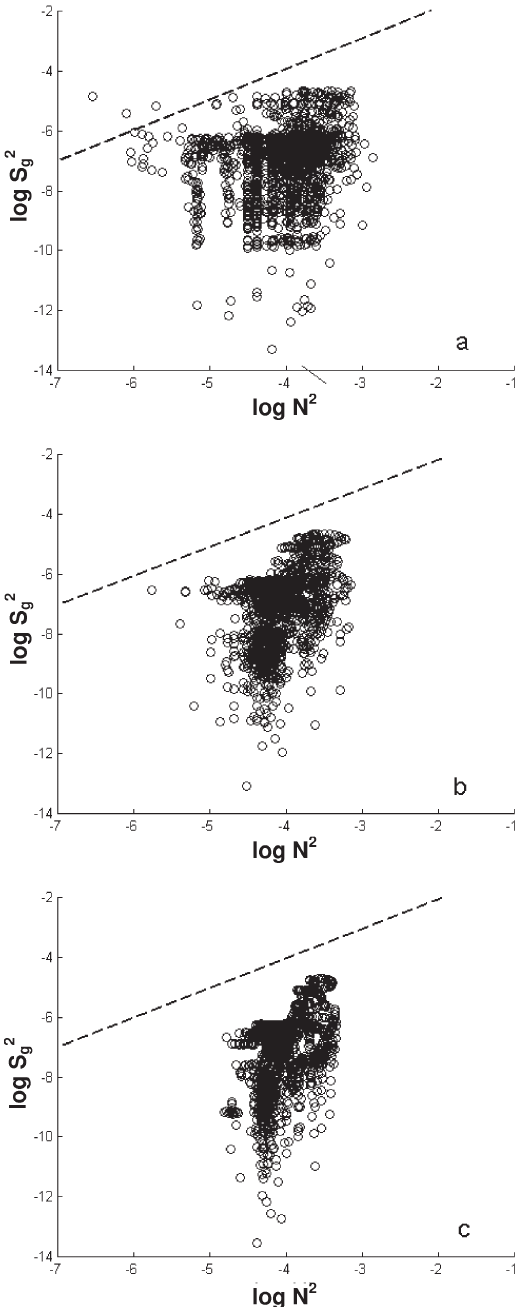
2 as a function of log N 2 for the F IG . 4. – Scatter diagram of log S g Blake Plateau data with (a) no smoothing, (b) 7 m smoothing, and (c) 21 m smoothing. The dashed line illustrates the Ri = 1 g 2 condition (log N 2 = log S g